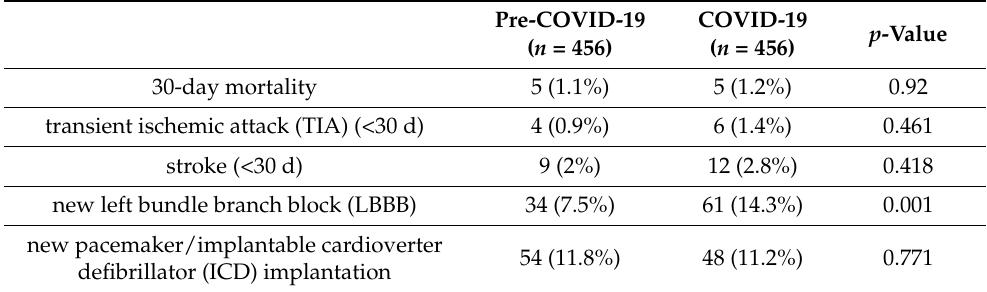
Table 10. Outcome parameters